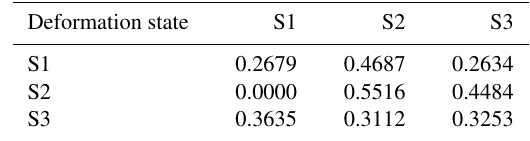
Table 3. State transition entropy of Xintan landslide.